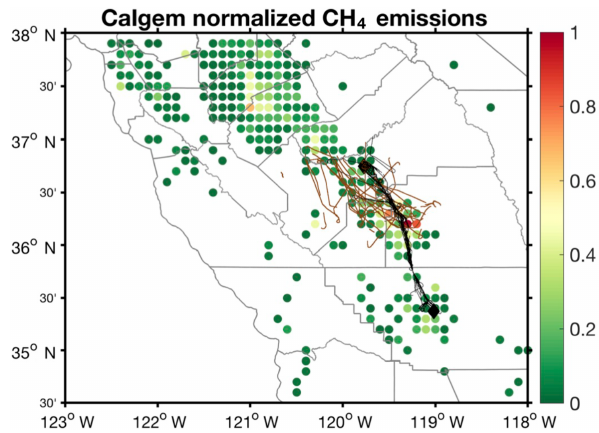
Figure 10. Normalized CALGEM inventory emissions showing the distribution and relative magnitude of methane sources with flight tracks (EPA flights in brown and RLO flights in black) superim- posed. At the northern and southern ends of the RLO flights are black diamonds representing Fresno and Bakersfield,